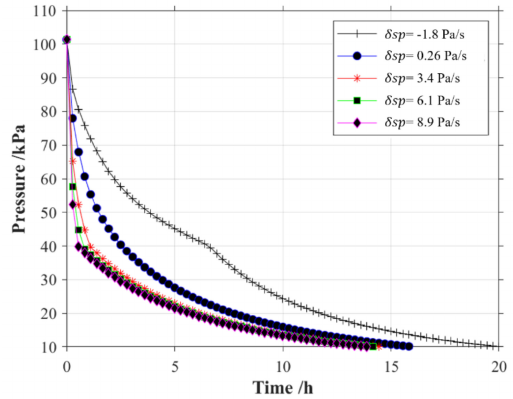
Figure 8. Pressure drop curve for different δ sp .